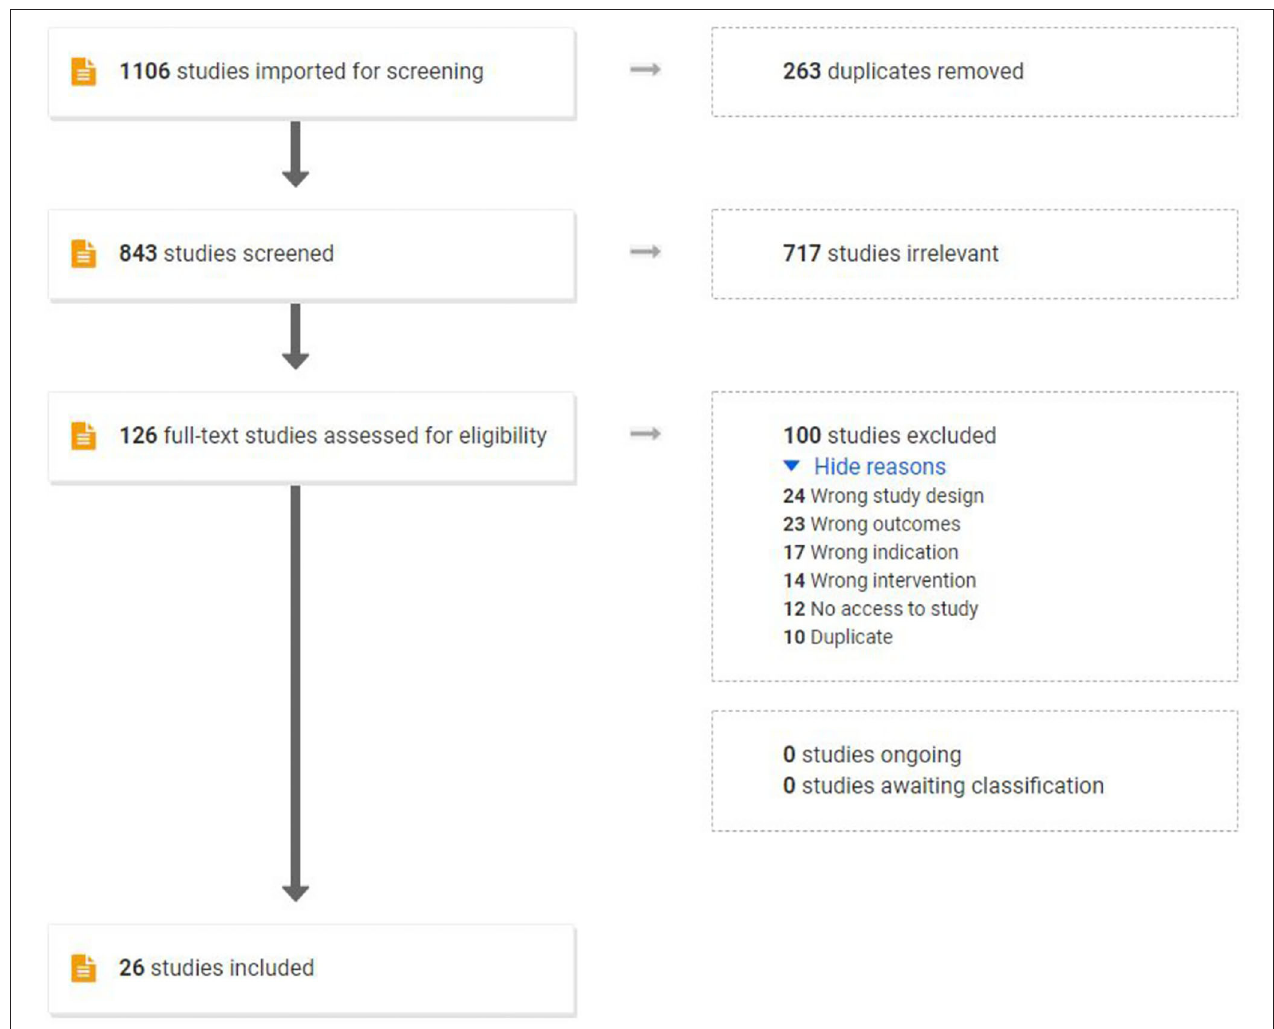
FIGURE 2 | Flow chart of study selection using PRISMA